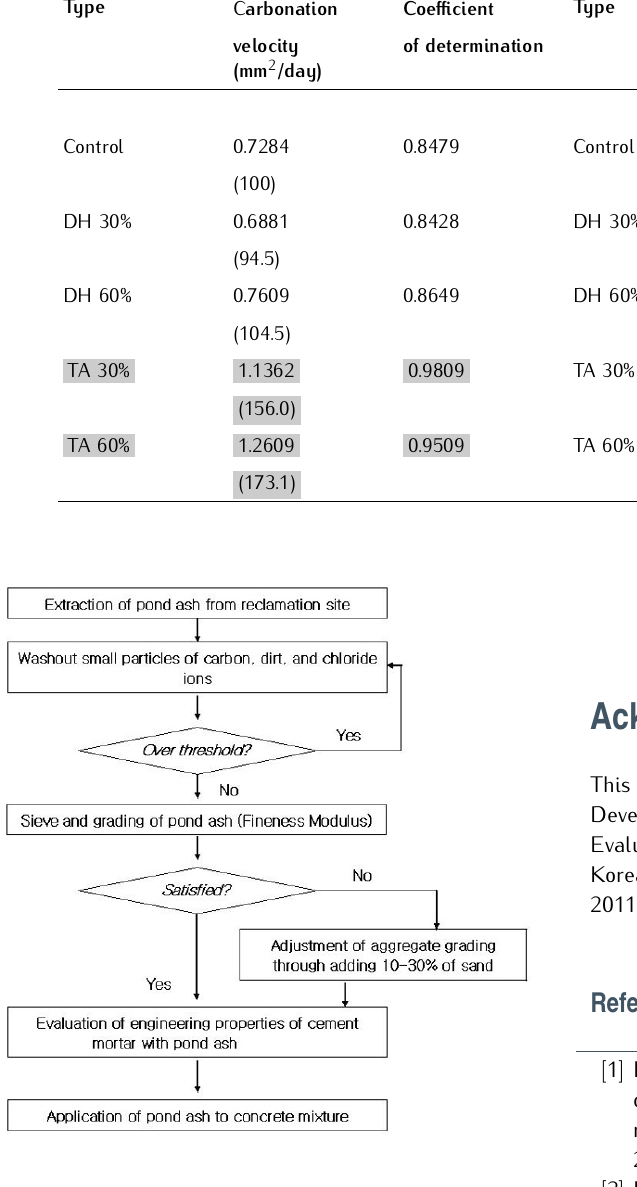
Figure 14. Process of PA for replacement of fine